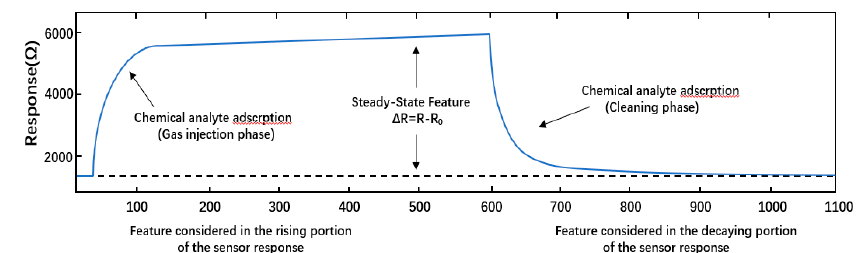
Figure 1. Typical information of sensor response. Typical response of a metal-oxide based chemical sensor to 30ppmv of Acetaldehyde. The curve shows the three phases of a measurement: baseline measurement (made with pure air), test gas measurement (when the chemical analyte is injected, in gas form, to the test chamber), and recovery phase (during which the sensor again is exposed to pure air; the recovery time is usually much longer that the gas injection phase).